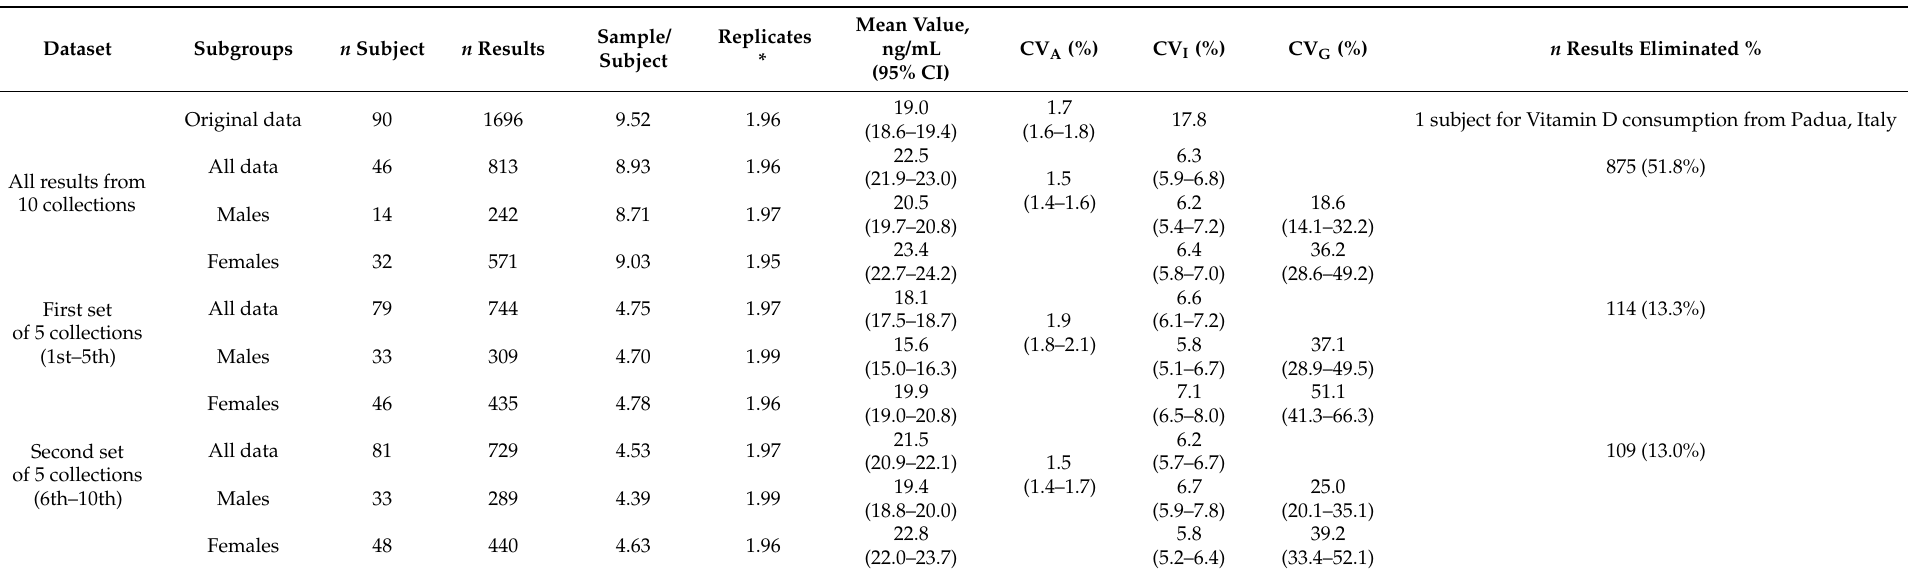
Table 1. Examination coefficient of variation (CV A ), within-subject (CV I ), and between-subject (CV G ) biological variation estimates with 95% confidence intervals (CI) of twenty-five- hydroxy vitamin D